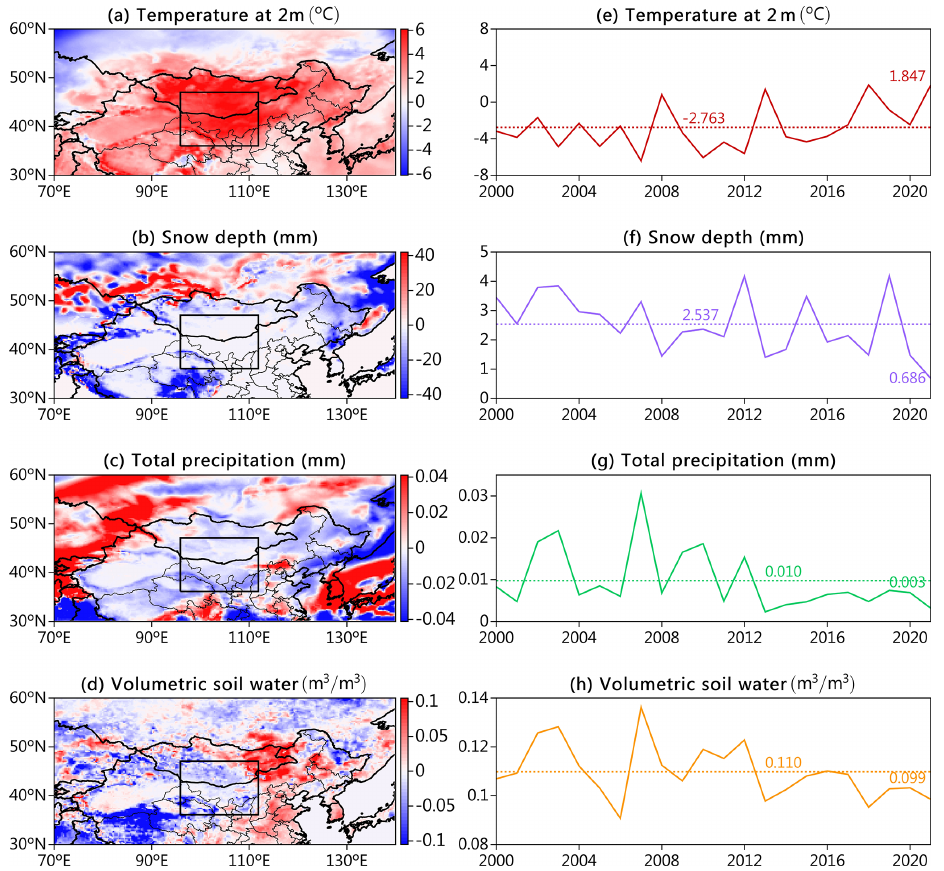
Figure 18. ERA5 meteorological anomalies 2 weeks (i.e., 1–14 March 2021) before the 3.15 event: (a–d) anomalies of temperature at 2m ( ◦ C), snow depth (mm), total precipitation (mm), and volumetric soil water (m 3 m − 3 ) with reference to the 2000–2020 climatology. (e–h) Time series of ERA5 meteorological factors 2 weeks before the 3.15 event averaged over the GD (black box in a–d : 36–47 ◦ N, 96– 112 ◦ W). The numbers and dashed lines represent the multi-year averages and their locations, respectively. Also, the magnitude for 2021 is